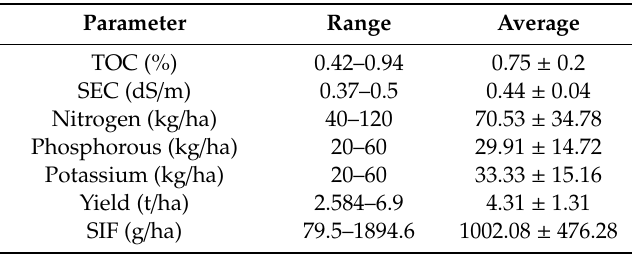
Table 2. Range, average, and standard deviation of the parameters used for developing the ANN for modelling nitrous oxide (N 2 O)